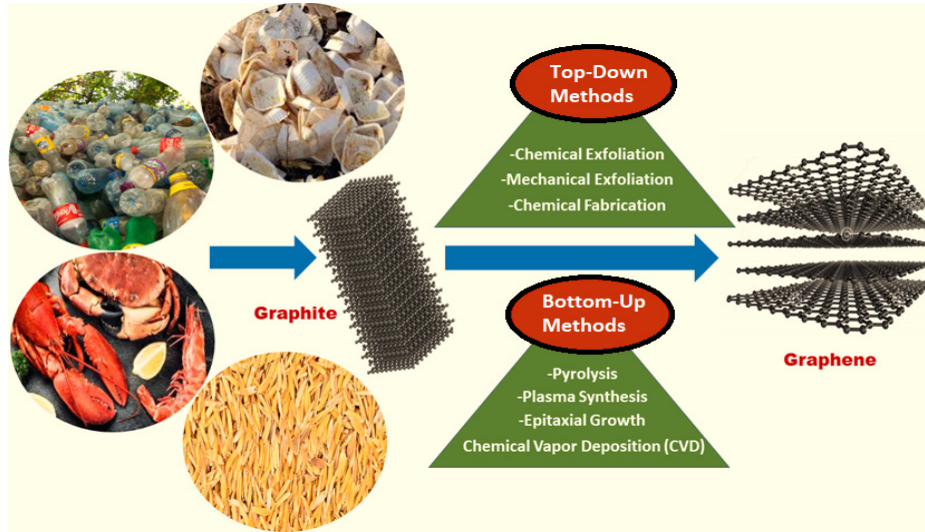
Figure 1. Schematic illustration of graphene synthetic routes from waste sources.